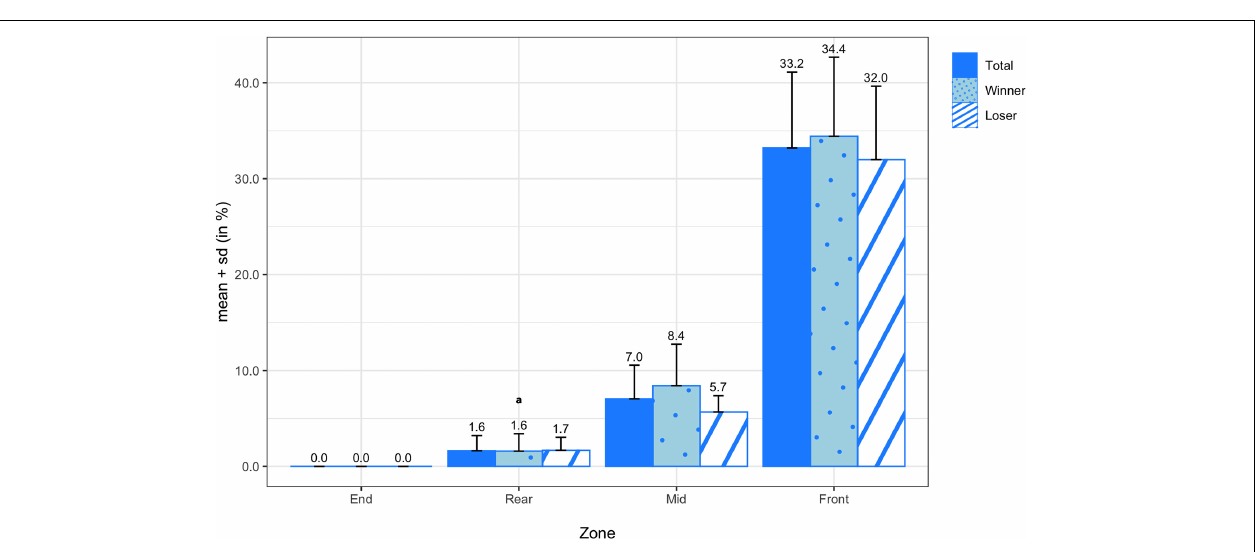
thrown from the mid zone (39.44 ± 6.57%) and rear